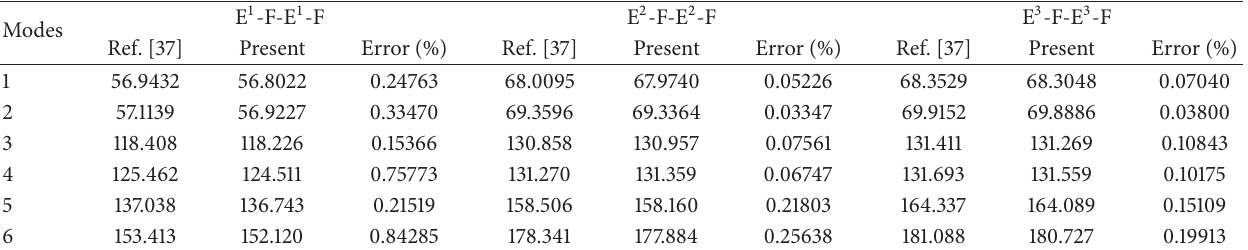
Table 9: First six frequency parameters Ω = 𝜔𝐿 2 √𝜌ℎ/𝐷 for an open conical shell subjected to various classical-elastic combined boundary conditions.